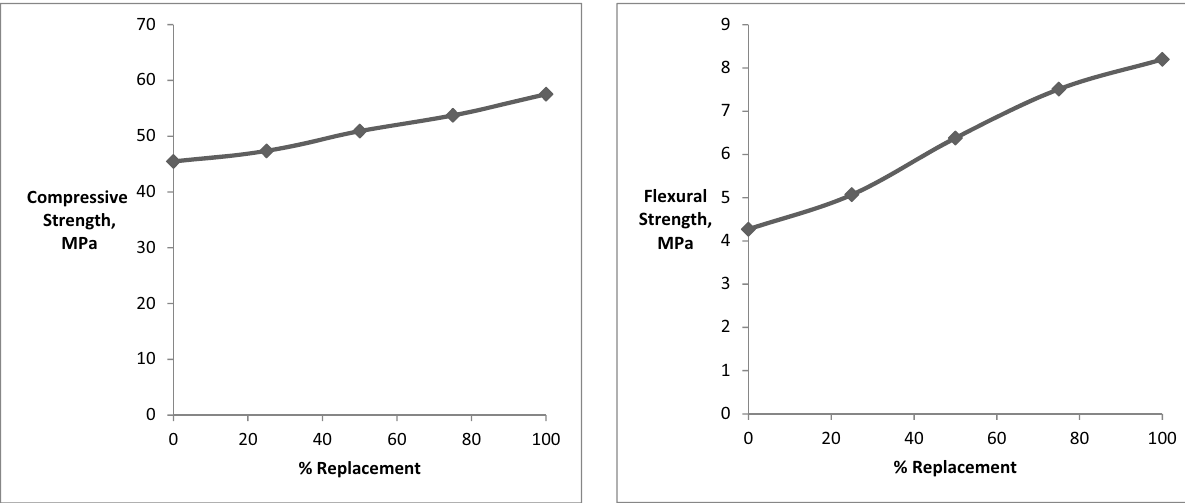
Figure 9: Relation between % replacement and fl exural strength of concrete modi fi ed with PC superplasticizer.